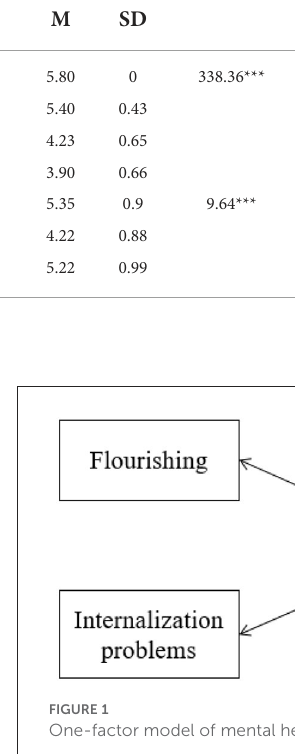
found that there were significant differences. The flourishing of mentally healthy people was higher than that of those with mental illness ( t = 9.64, p < 0.001), and the score of internalization problems was lower than that of mental illness ( t = − 18.74, p <